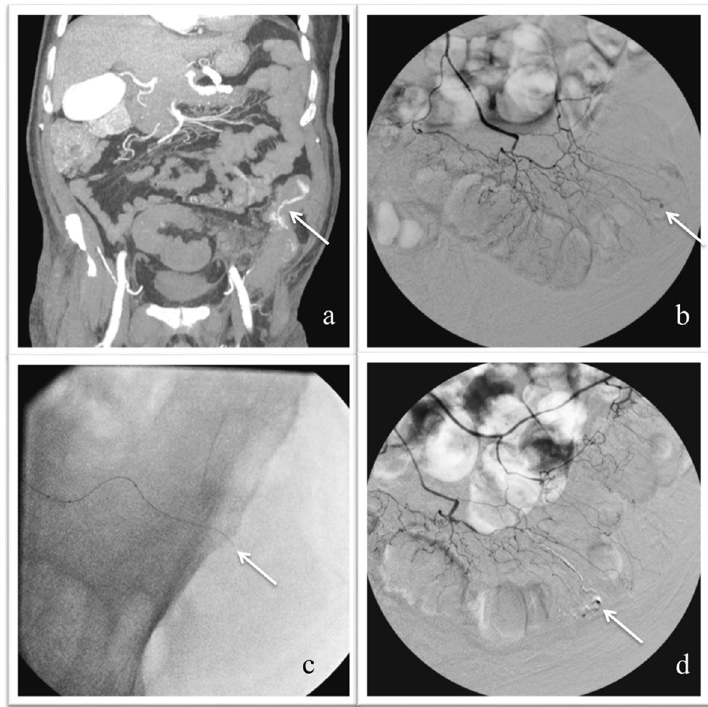
Fig. 1 a – d CT MPR images in a patient suffering from lower gastrointestinal bleeding show active diverticular bleeding within the lumen of the descending colon ( a ). Selective inferior mesenteric artery angiography (IMA) shows a contrast extravasation from a branch of the sigmoid artery ( b ). After superselective catheterization of the target vessel with a 1.7 Fr microcatheter ( c ), selective IMA post-embolization angiography confirms selective occlusion of the target vessel ( d